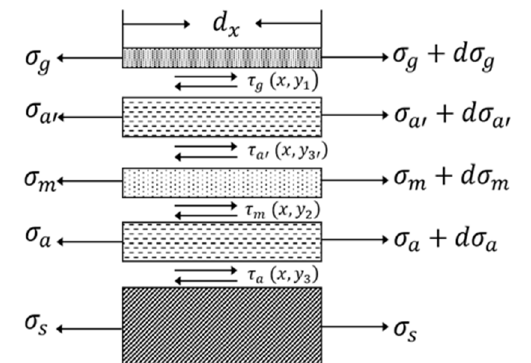
Figure 5. Strain transfer analysis diagram of a resistance strain-type transducer, in which layers of the resistance strain-sensitive grids and two layers of glue are considered. The substrate film and the sensitive grids are bond by the ground adhesive glue and upper adhesive glue in the y-axis direction. The strain propagates along the x-axis direction. The strain transfer characteristics can be analyzed by the elastic-mechanical shear lag theory [22].